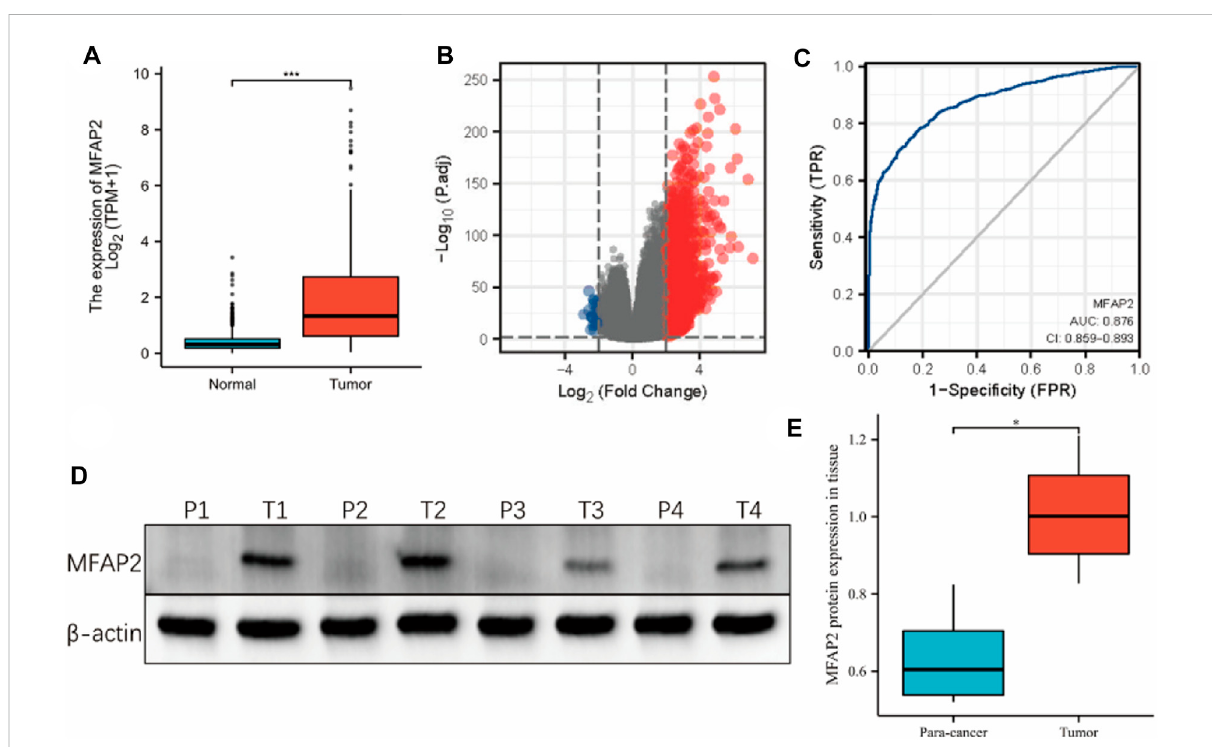
FIGURE 1 Expression of MFAP2 in tumor and normal tissues of patients with glioma. (A) Higher MFAP2 expression in glioma compared to that in normal tissue from the TCGA-GTEx database. (B) DEGs between the high- and low-MFAP2 expression groups. (C) ROC analysis of MFAP2 revealed promising differentiationability between tumor and normal tissues. (D) and (E) Representative Westernblotand thecorresponding expression levels of MFAP2 protein in para-cancer and tumor tissues. p -value signi fi cance codes: *** p ≤ 0.001, ** p ≤ 0.01, * p ≤